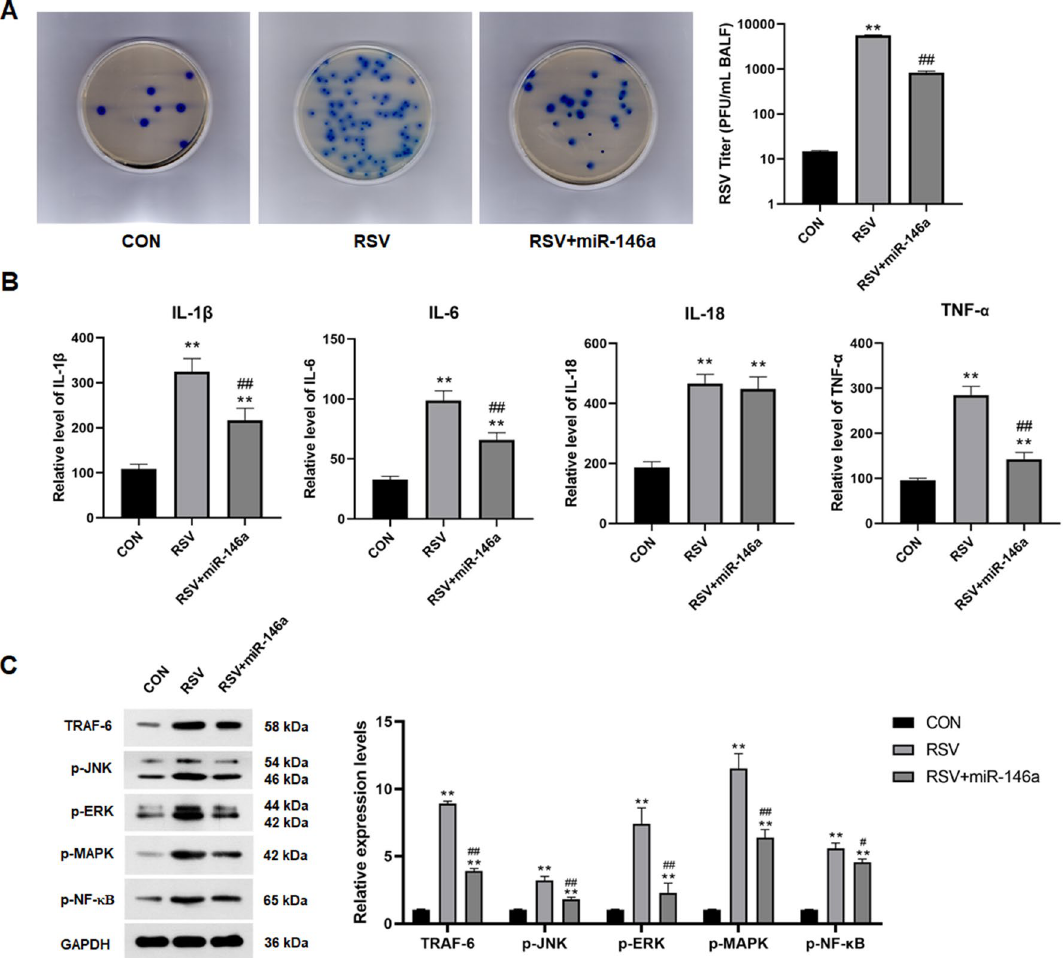
Figure 5. Overexpression of miR-146a inhibits RSV-induced inflammatory cytokines release and JNK/ERK/ MAPK/NF-κB pathway activation in BALF of rats. ( A ) Overexpression of miR-146a significantly reduced RSV titer in rat BALF; ( B ) Levels of inflammatory cytokines, including IL-1β, IL-6, IL-18 and TNF-α, in BALF of rats in each group; ( B ) Protein expression levels of JNK, MAPK, ERK and NF-κB in BALF of rats in each group; ** P < 0.01, compared with the CON group; # P < 0.05, ## P < 0.01, compared with the RSV group; n =